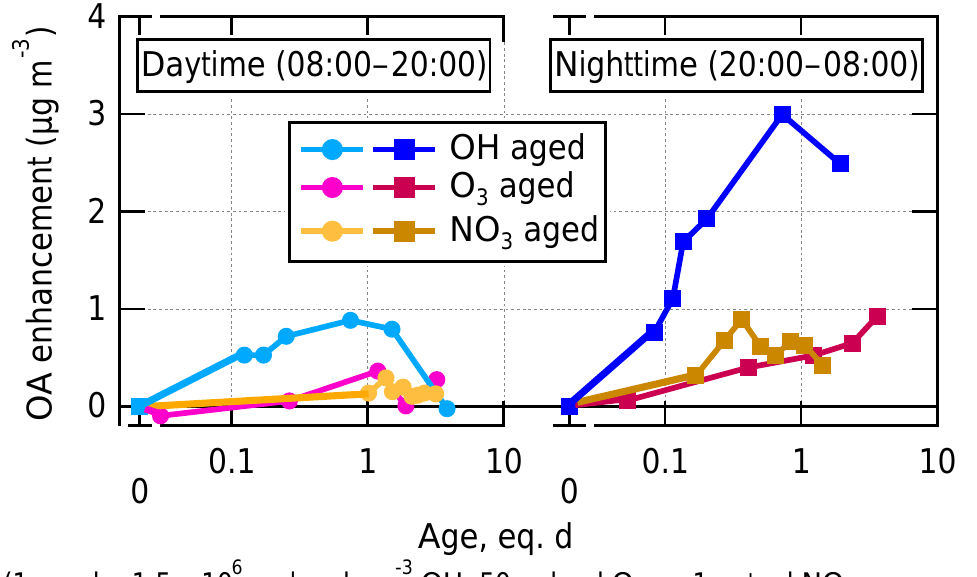
Figure 6. OA enhancement vs. age in eq. d for OH, O 3 , and NO 3 oxidation, separated into daytime (08:00–20:00LT) and nighttime (20:00– 08:00LT) data. All data are LVOC fate corrected. OH oxidation produced several-fold more OA enhancement than O 3 and NO 3 oxidation. OH-aged OA enhancement data (only for <5 eq. d aging where the LVOC fate correction could be applied) are taken from Palm et al.